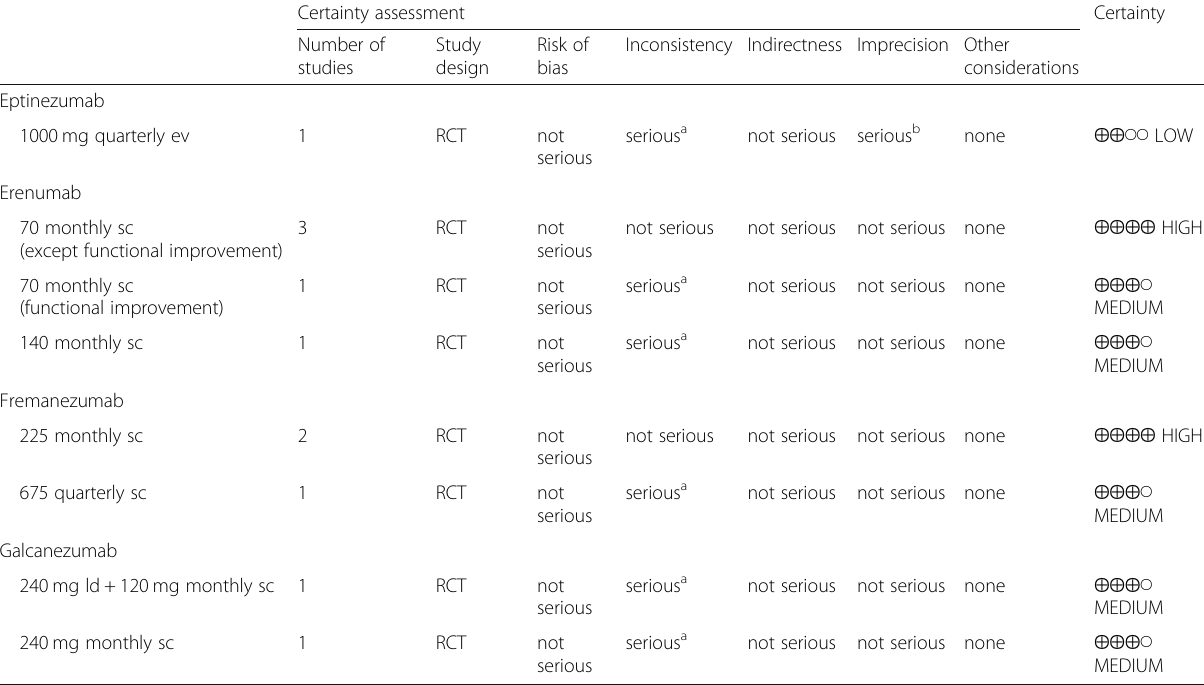
Table 3 Certainty in the assessment of efficacy outcomes for anti-calcitonin gene-related peptide monoclonal antibodies for prevention in episodic migraine Certainty assessment Certainty Number of studies